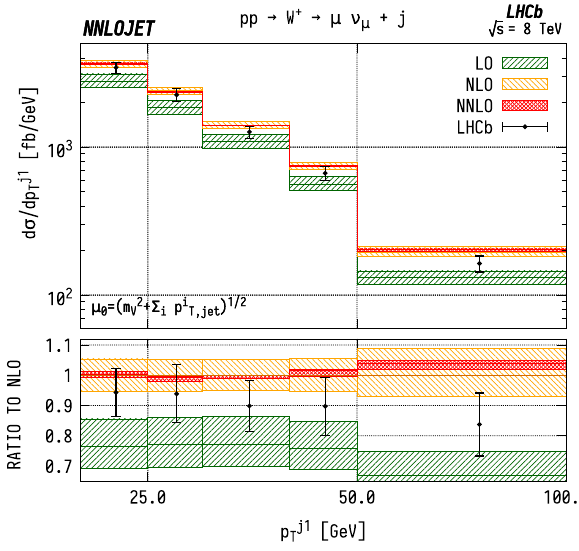
Fig. 4 Cross section differential in the p T of the leading jet for W + production. See Fig. 3 for details